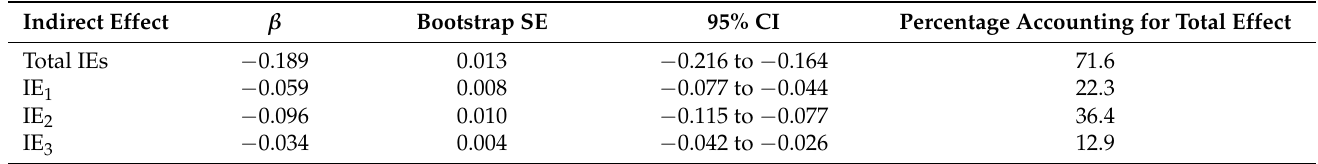
Table 4. Indirect effects of physical exercise on psychological distress in